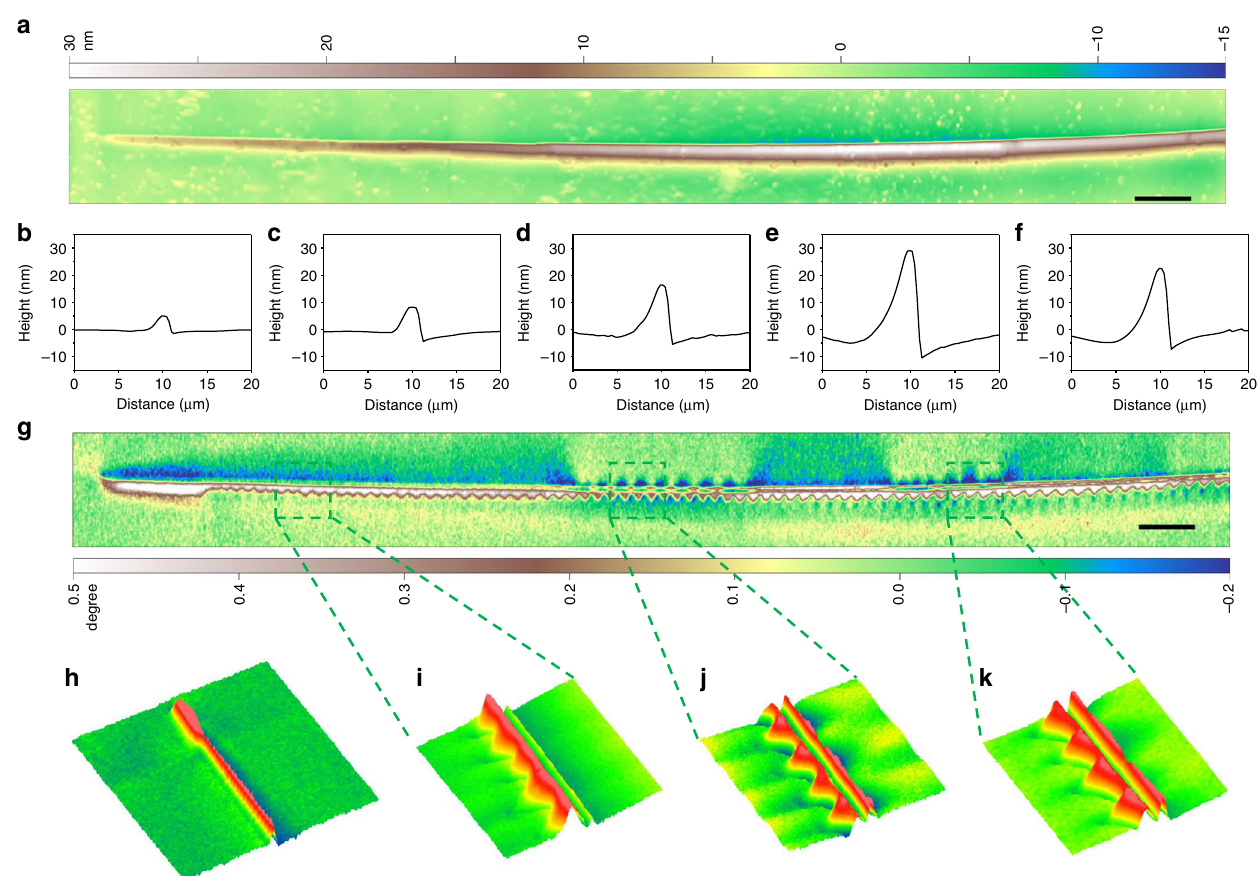
Fig. 2 AFM and MFM micrographs of a 200- μ m long shear band. a , g AFM topographic image ( a ) and the corresponding MFM phase image ( g ) covering 200 µ m for a single shear band. b – f Height pro fi les at different locations along the shear band. h 70 × 70 µ m 2 3D MFM phase image at shear band propagation front. i – k Zoom-in 3D MFM phase images in the 10 × 10 µ m 2 regions marked by the green squares in g . Scale bar, 10 µ m in a and